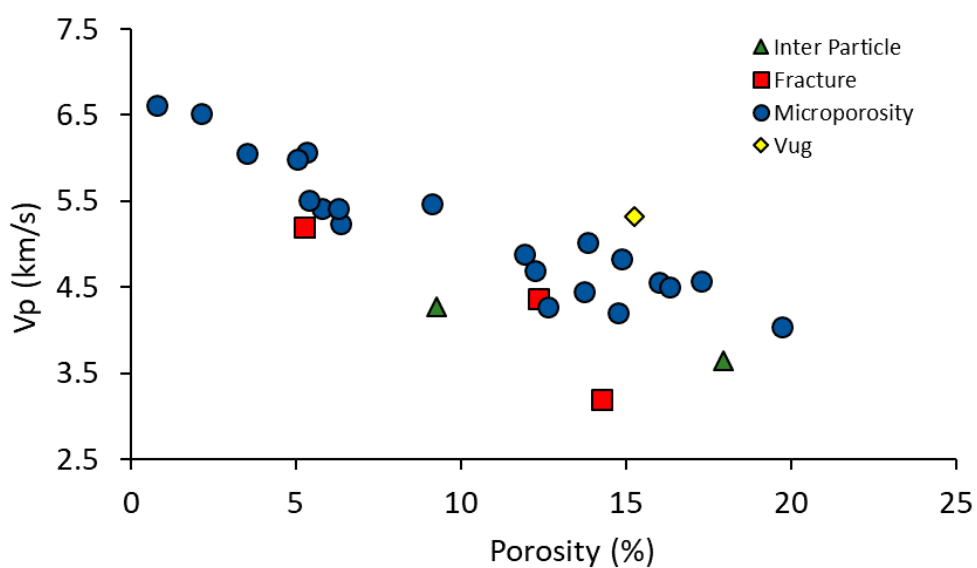
Figure 12. Pore types impact on the compressional velocity (Vp). Samples dominated with fractures and interparticle pores have the lowest velocities, while samples dominated by vug pores (open burrows) have the highest velocity.